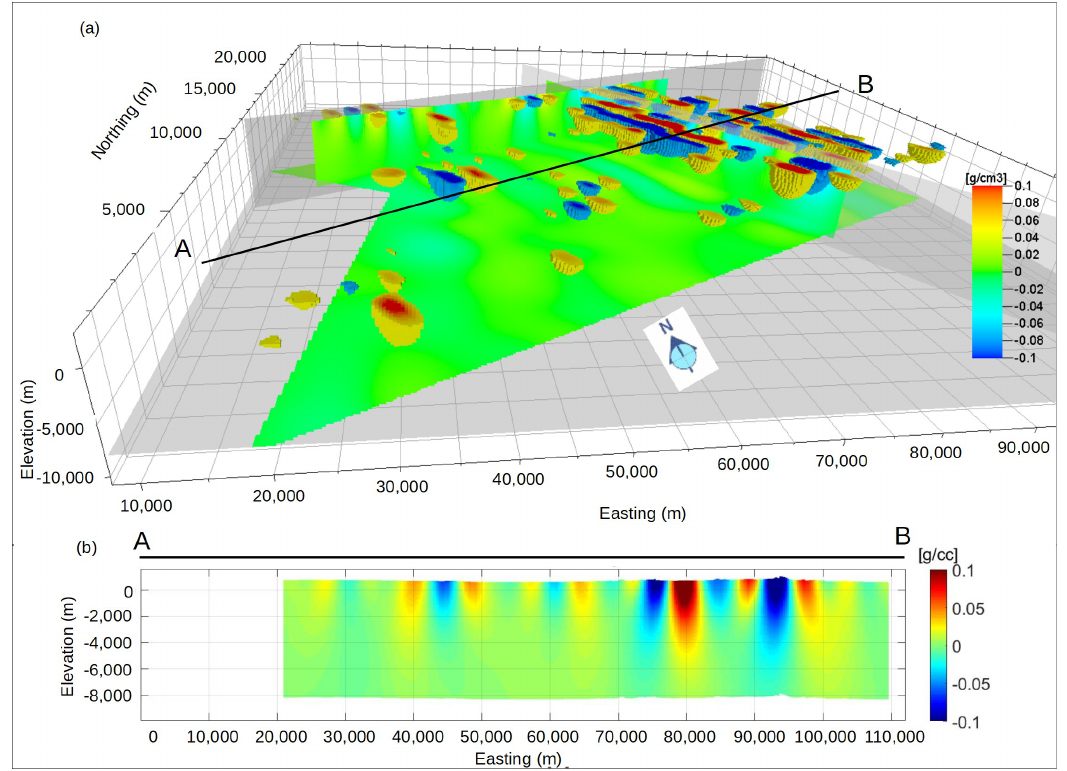
Figure 4. Density model recovered from the airborne gravity data. Panel ( a ) shows a perspective image of the inverse density model as viewed from the southwest. Panel ( b ) shows a vertical cross section of the density model along line A to B. Note that the apparent vertical elongation of the density anomalies in the vertical cross section is caused by exaggeration of the vertical scale with respect to horizontal